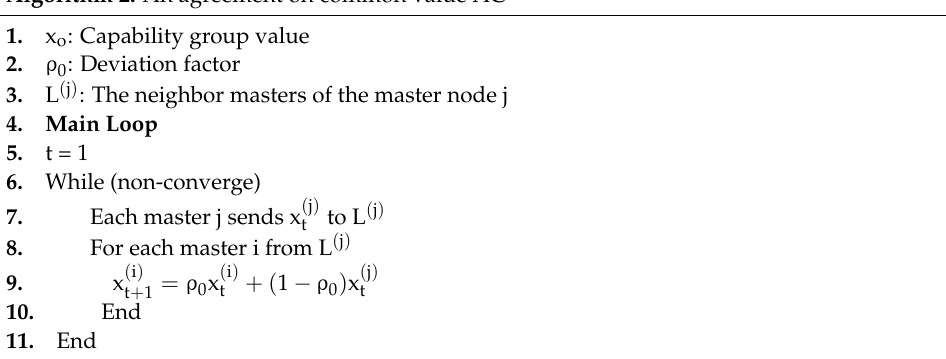
Algorithm 2: An agreement on common value